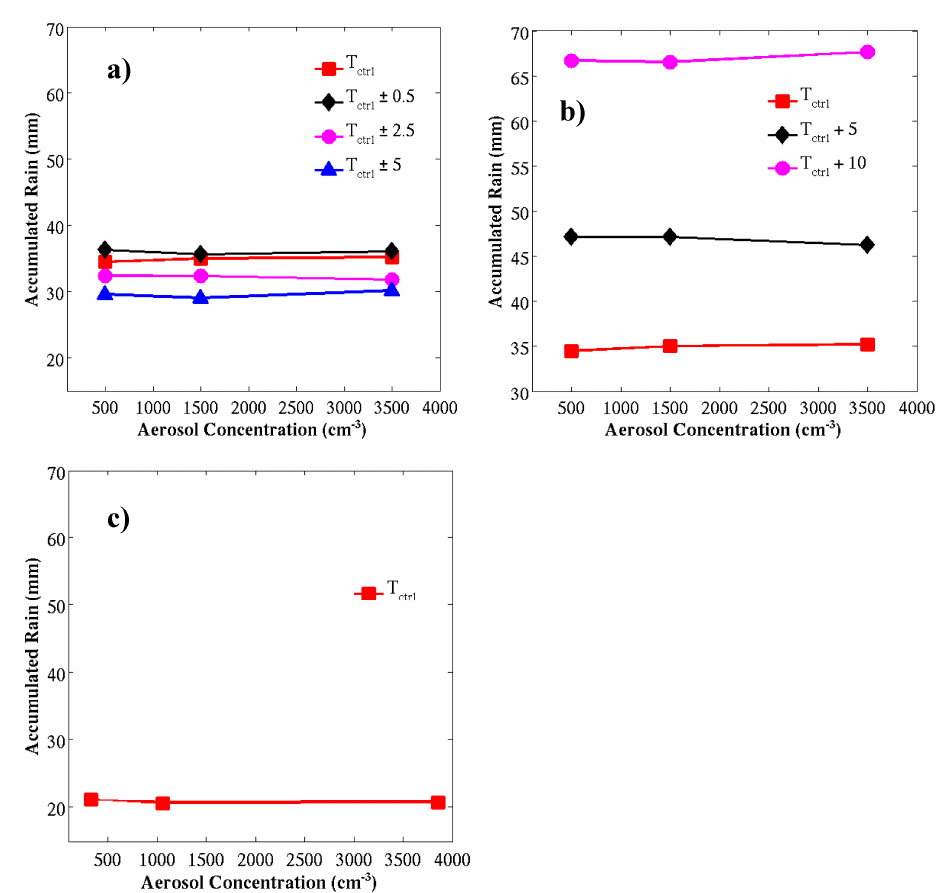
Figure 6. Sensitivity of accumulated rain to aerosol and temperature perturbations ( a ) random temperature perturbation; ( b ) uniform temperature perturbation; and ( c ) prognostic CCN